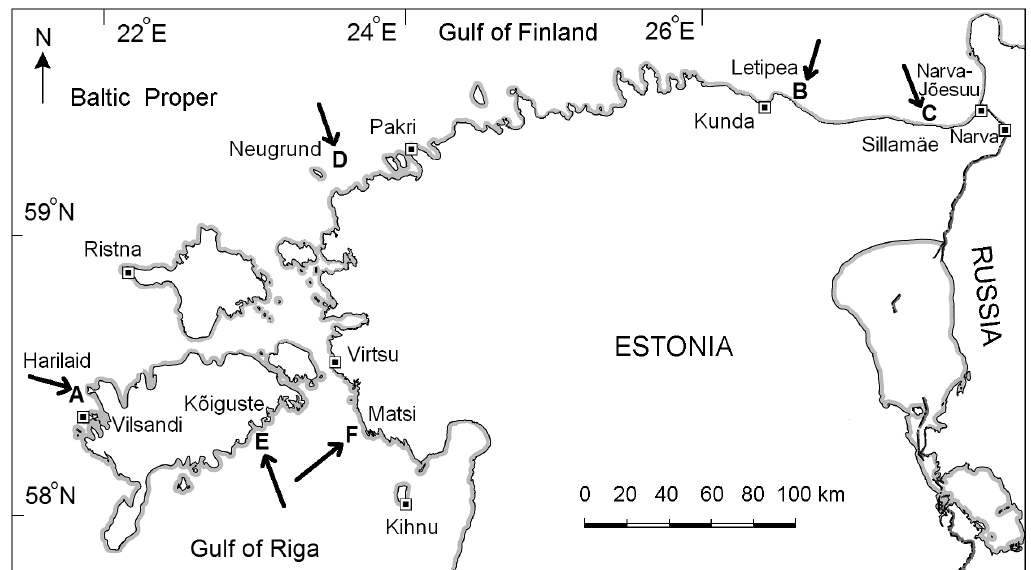
Fig. 1. Map of the study area. Wave measurement and modelling locations are denoted with letters (see also Table 1) accompanied by arrows which indicate the directions of the longest fetches. The locations of the EMHI weather stations used in calibrations or hindcasts are marked with !